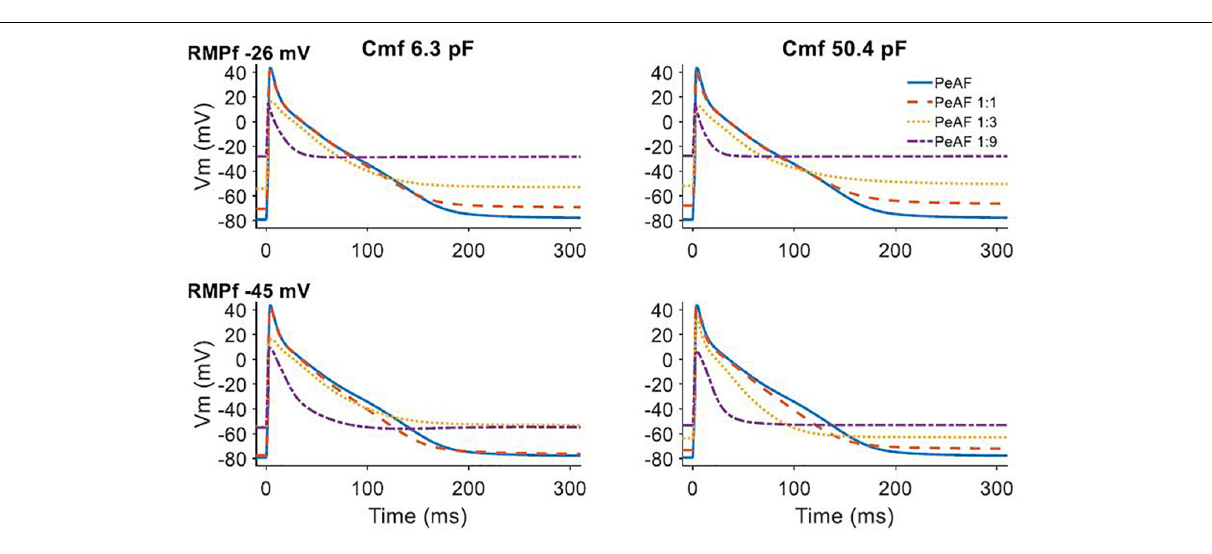
FIGURE 2 | Effect of fibroblast and myocyte coupling under persistent atrial fibrillation (PeAF) electrical remodeling in RA (baseline model). First and second rows show fibroblasts resting membrane potential (RMPf) of –26 and –45 mV, respectively, for a fibroblast membrane capacitance (Cmf) of 6.3 pF (first column) and 50.4 pF (second column). The different traces are action potentials of isolated myocytes under PeAF (blue), one myocyte under PeAF coupled to 1 fibroblast (1:1) (dashed orange), one myocyte under PeAF coupled to three fibroblasts (1:3) (dotted yellow), and one myocyte under PeAF coupled to nine fibroblasts (1:9) (dotted-dashed